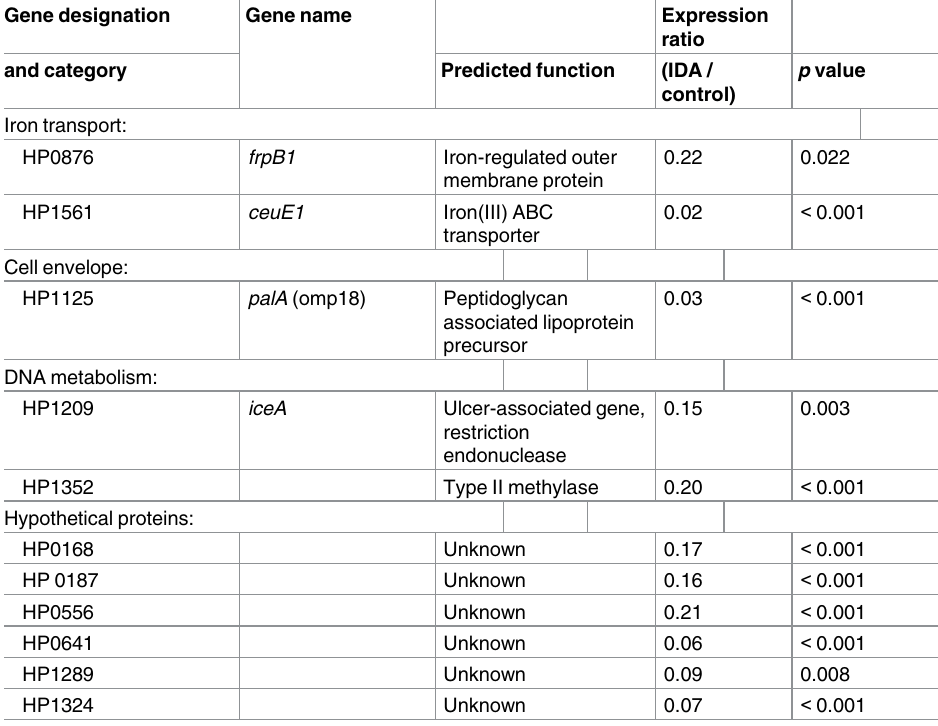
Table 4. H . pylori genes with lower expression in IDA